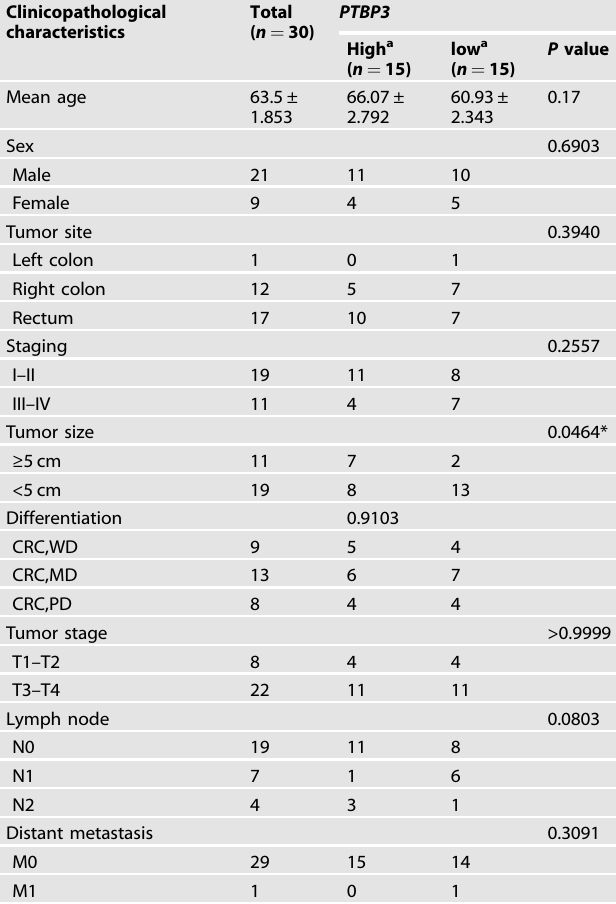
Table 1. Clinic-pathological characteristics of enrolled patients. Clinicopathological